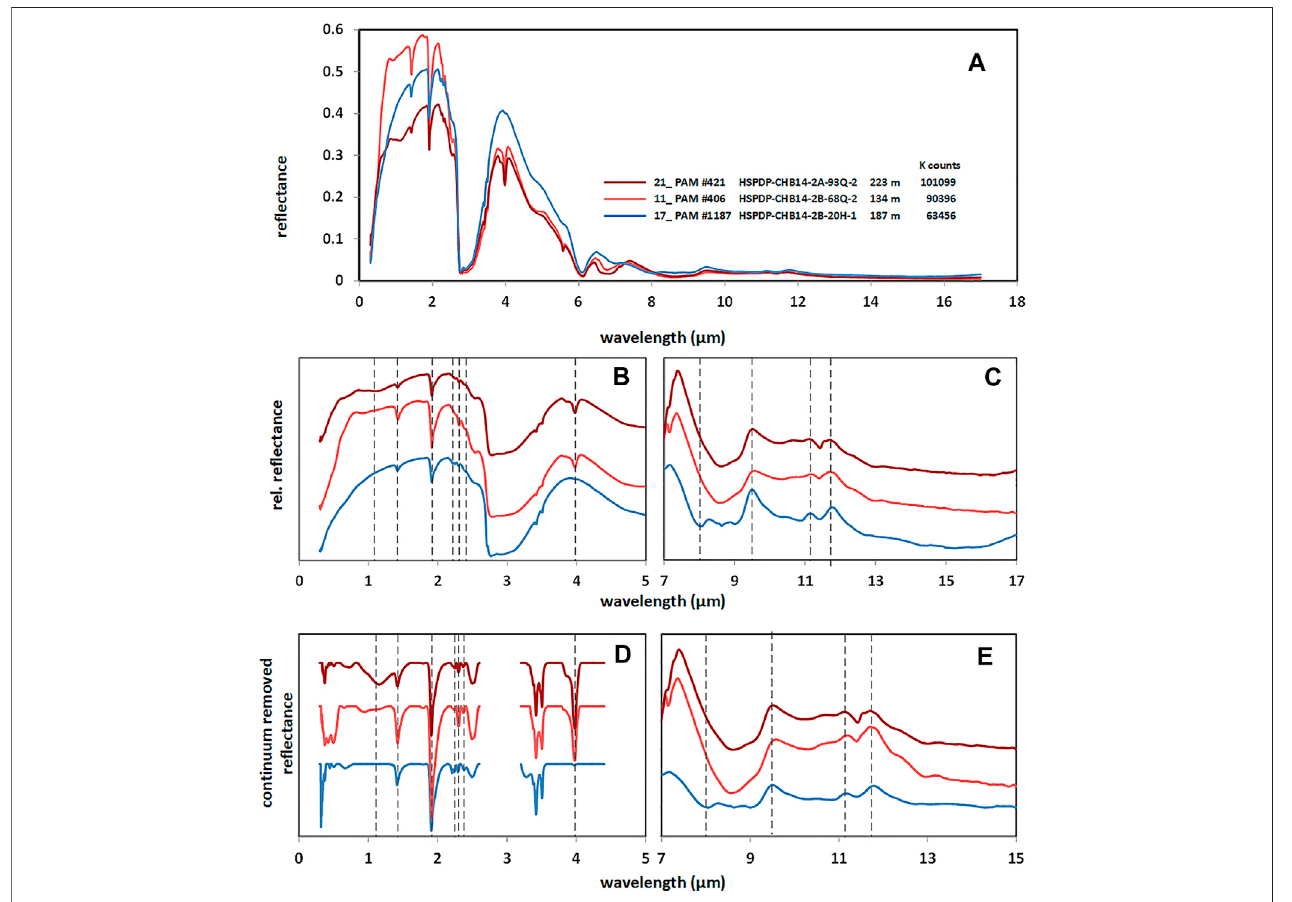
FIGURE 3 | (A) Typical re fl ectance spectra of three selected CHB14-2 drill core samples in the wavelength range from 0.3 to 7 μ m. (B, C) Detailed view of the 0.3 – 5 μ m and the 7 – 17 μ m range. (D, E) Continuum removed spectra between 0.25 and 5 μ m and between 7 and 17 μ m. For reasons of clarity, the spectra are presented with an offset in re fl ectance (left and right offsets are